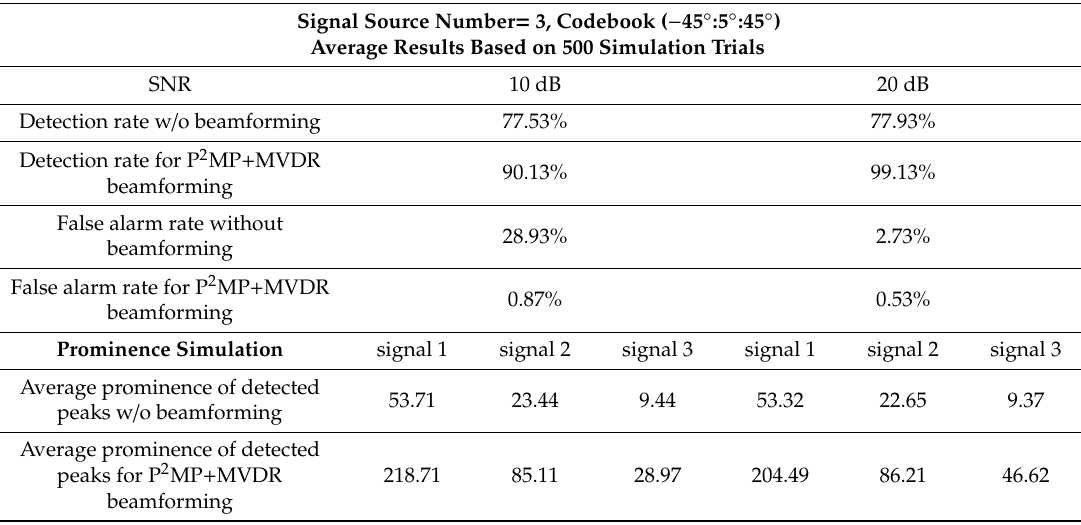
Table 4. FMCW detection results with and without